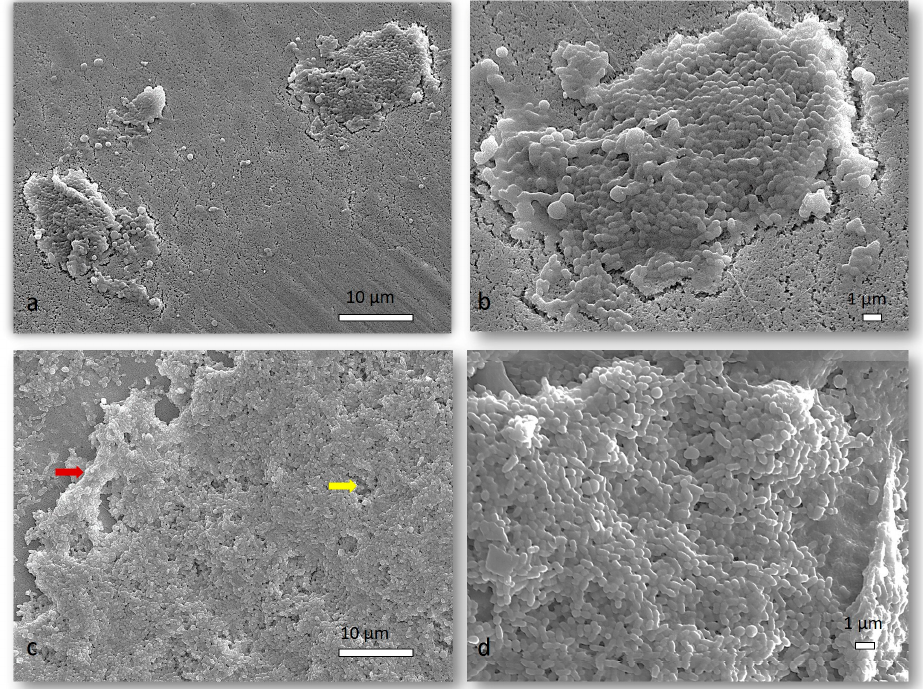
Figure 4. Representative SEM micrographs of a 72-h biofilm on Cytoplast d-PTFE. Different magnifications of salivarius mixed biofilm are presented in ( a , b ), while different magnifications of non-salivarius mixed biofilm are presented in ( c , d ); Red arrow—EPS bridging between microcolonies; Yellow arrow—aggregates between microcolonies connected by channels; Magnification of 2000 × and 5000 ×.